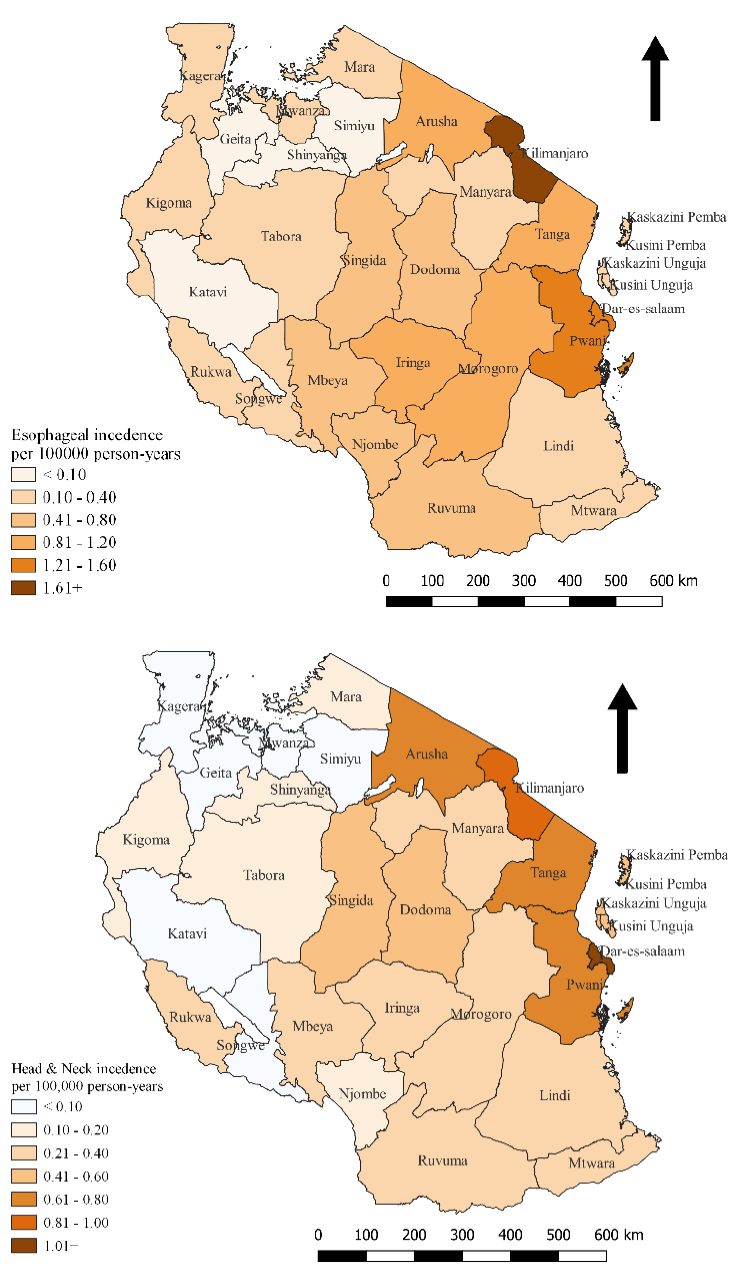
Figure 1. The figures show the number of cancer incidences per 100,000